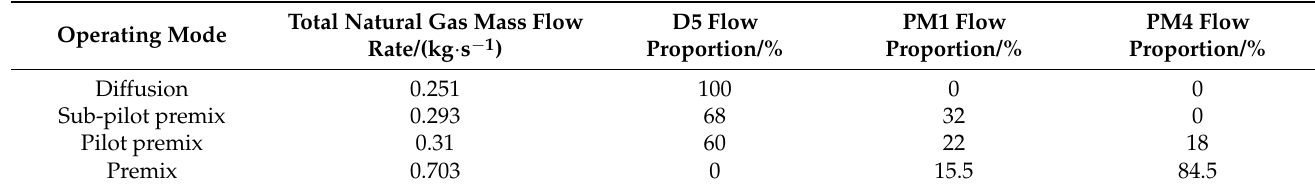
Table 4. Fuel allocation ratio at each stage of power-up